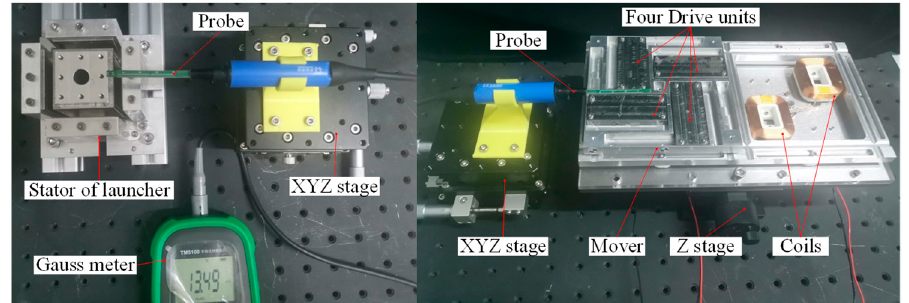
Figure 15. Magnetic-field-leakage measurement.